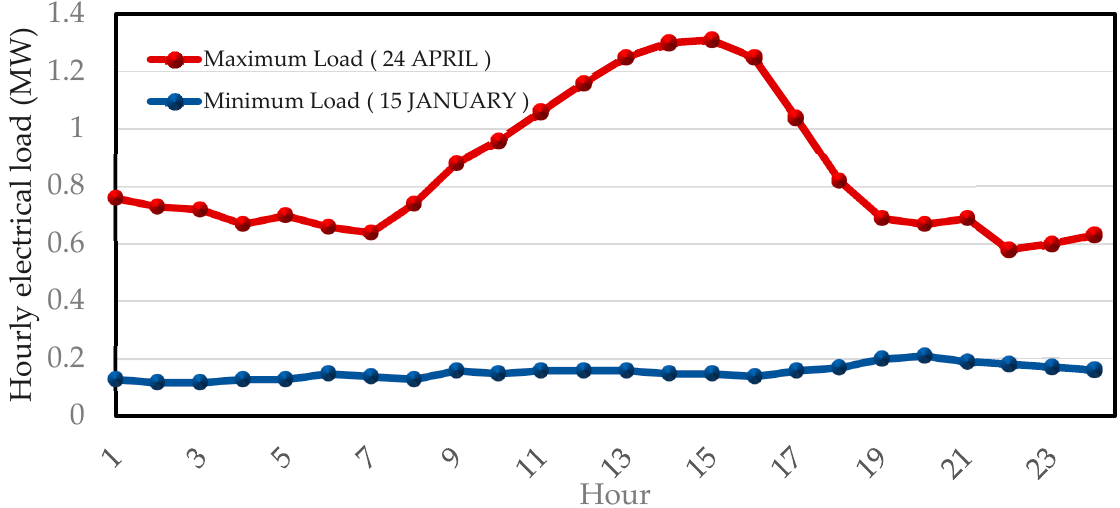
Figure 6. Load profile for a day in summer (maximum load) and winter (minimum load) in 2020.